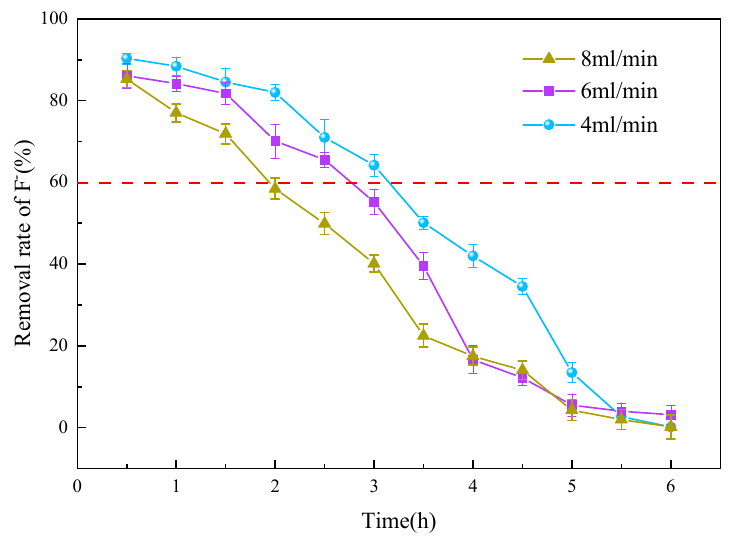
Figure 14. Effect of flow speed in an adsorbent column. The initial F − concentration was set to 1 × 10 − 2 g/L, and pH was set to 7.